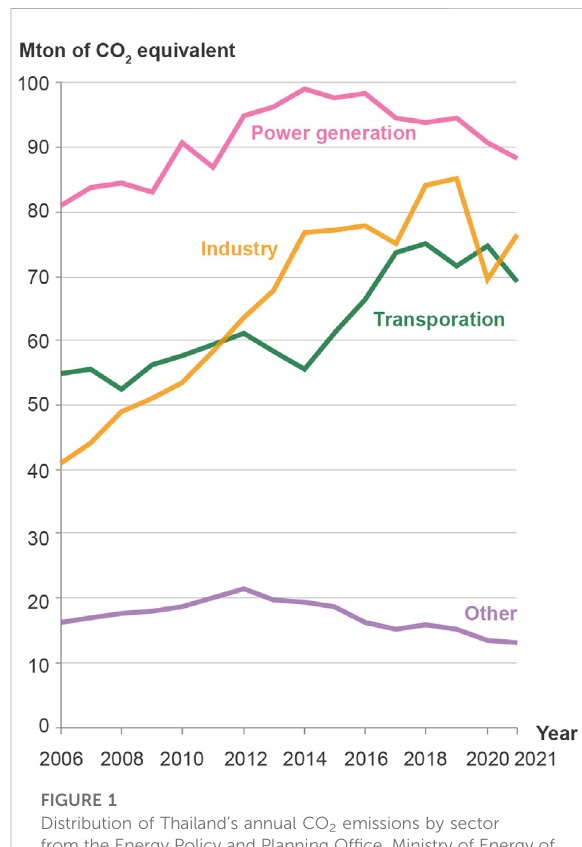
FIGURE 1 Distribution of Thailand ’ s annual CO 2 emissions by sector from the Energy Policy and Planning Of fi ce, Ministry of Energy of Thailand (Energy Policy and Planning Of fi ce (EPPO),